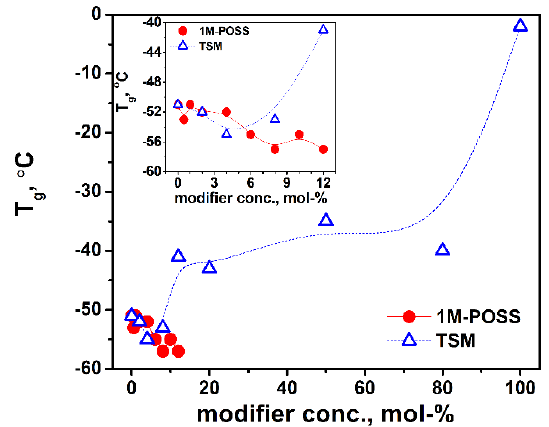
Figure 13. Glass transition temperature, T g , of LM/1M-POSS and LM/TSM copolymers as a function of the modifier content. The lines are eye guides.